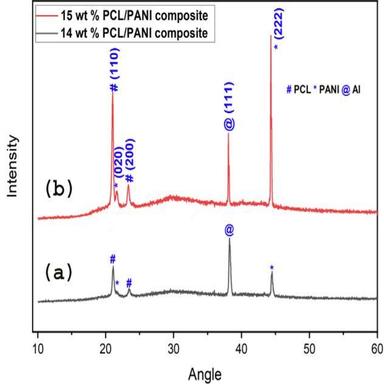
XRD patterns of (a) 14 wt% and (b) 15 wt% PCL and PANI nanocomposites.